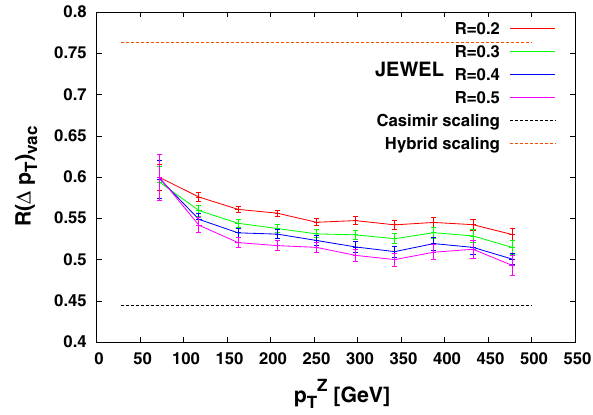
Fig. 1 R (Δ p T ) v ac as a function of the initial parton p T